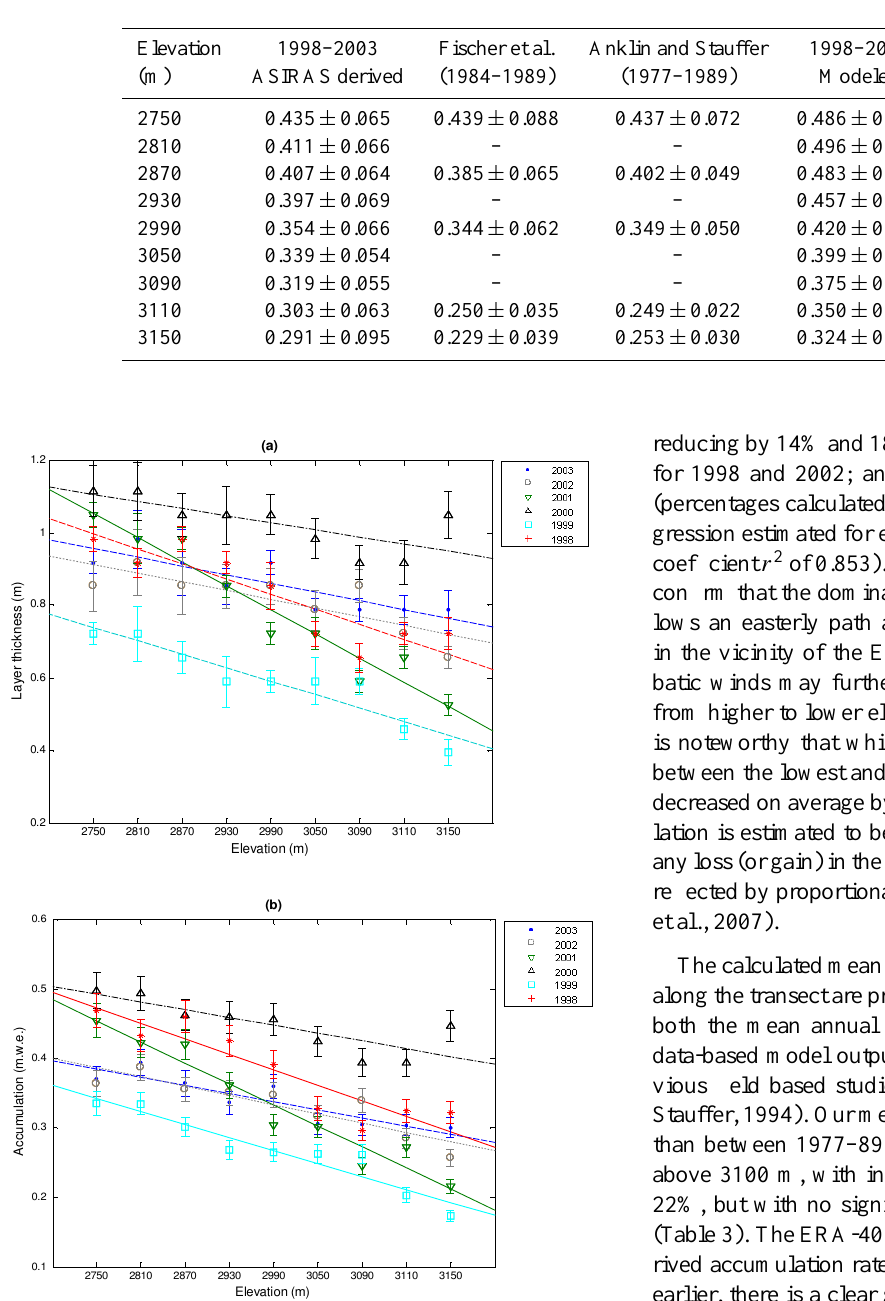
Table 3. Mean accumulation rates (in m.w.e.) with elevation derived from ASIRAS every 25km along the transect in conjunction with field data (Fischer et al., 1995; Anklin and Stauffer, 1994) and model results. The observed % change in accumulation are estimated from a comparison between the ASIRAS data and ground observations made by Anklin and Stauffer. (1994).